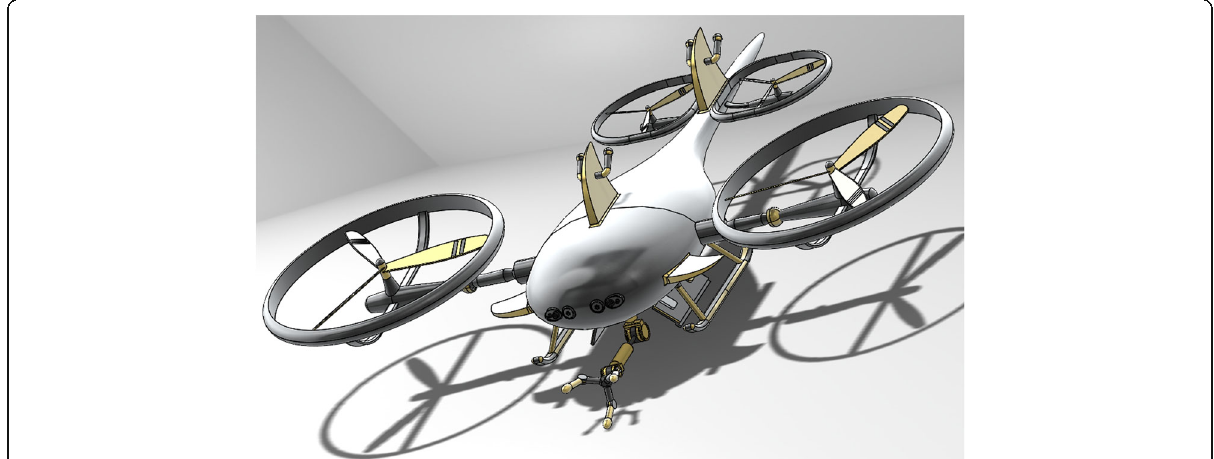
Fig. 4 Student submission for the team project